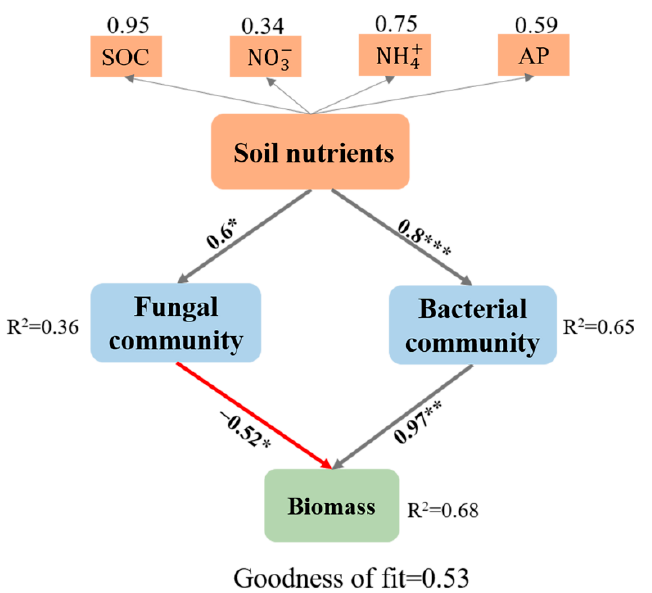
Figure 6. Partial least squares path modeling disentangling the direct and indirect pathways of the soil nutrients, fungal communities, and bacterial communities in Betula platyphylla biomass. Red and gray arrows indicate negative and positive effects, respectively. Asterisks represent significant effects (*, p < 0.05; **, p < 0.01; ***, p < 0.001). Only significant pathways are shown. Numbers on the arrows indicate standardized path coefficients.